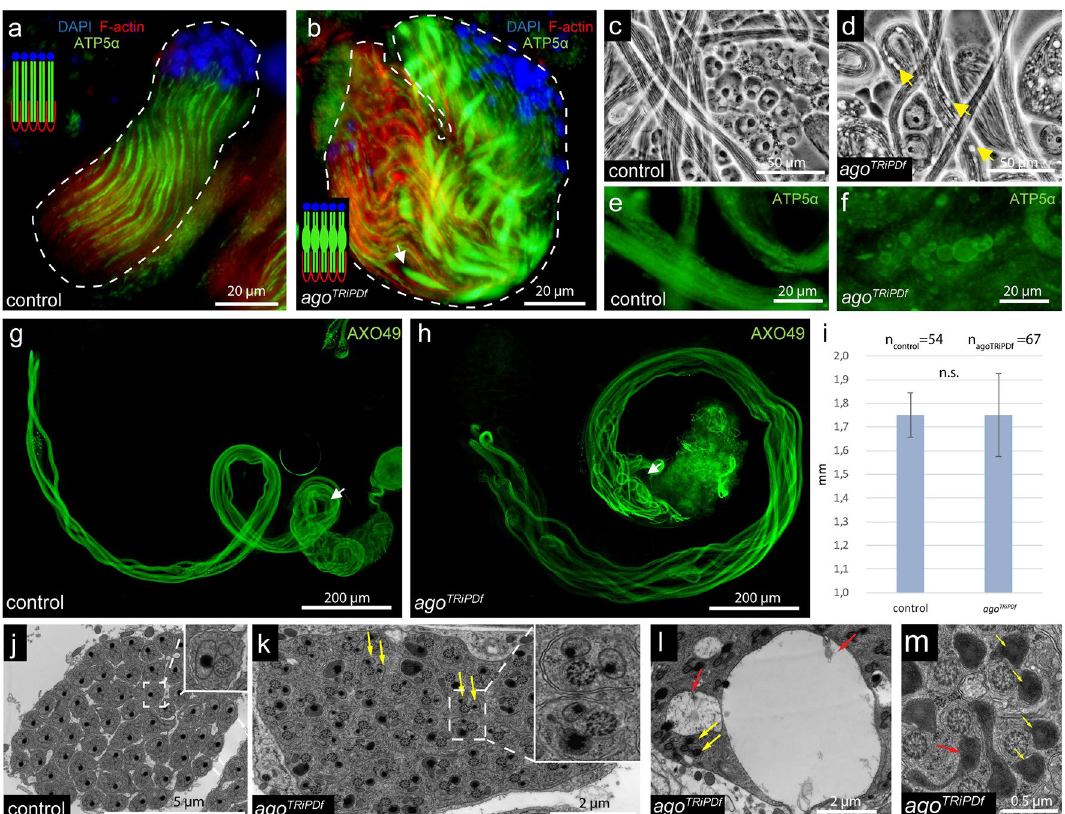
Figure 3. Mitochondrial abnormalities in ago TRiPDf testis. ( a-b ) ATP5alpha with anti-Atp5 (green), nuclei with DAPI (blue), and investment cones with Phalloidin-TexasRed were visualized on control ( a ) and on ago TRiPDf ( b ) in early elongating stages. Arrows show mitochondrial bulges next to the elongation complex in ago TRiPDf cyst( b ). ( c,d ) Phase-contrast images of elongating cysts in control ( c ) and ago TRiPDf ( d ) testis with vacuolar structures (arrows). ( e,f ) Anti-ATP5alpha staining on wild type ( e ) and ago TRiPDf ( f ) of elongated cysts: staining reveals mitochondrial swelling in ago TRiPDf spermatids. ( g,h ) Anti-AXO49 (green) staining on control ( g ) and on ago TRiPDf ( h ). Cysts from the ago TRiPDf testis elongate normally compared to control ( g,h,i ). Statistical significance was determined by Welch two-sample t-test ( i ).( j-m ) Transmission electron micrographs of wild type ( j ), ago TRiPDf ( k-m ). We can observe multiple mitochondrial abnormalities in ago TRiPDf , like paracrystalline accumulation in both mitochondrial derivatives ( k,l,m yellow arrows), mitochondrial swelling ( l , red arrows) and misshaped mitochondria ( m red arrow) The charts was created in Microsoft Excel 2016 MSO ver. 16.0.4266.1001 and processed in Adobe Illustrator CS6 ver.